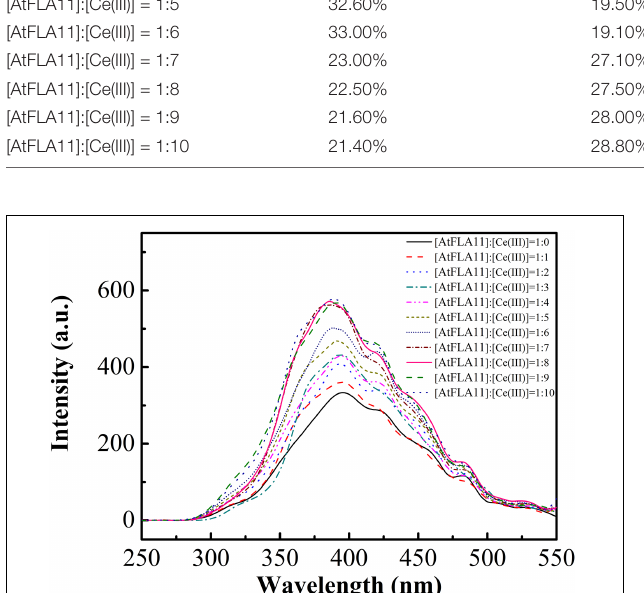
FIGURE 6 | The fluorescence spectra of 1.00 × 10 − 6 M AtFLA11 incubated with Ce(III) at different concentrations. The measurements were carried out 12 h after incubating AtFLA11 with Ce(III).